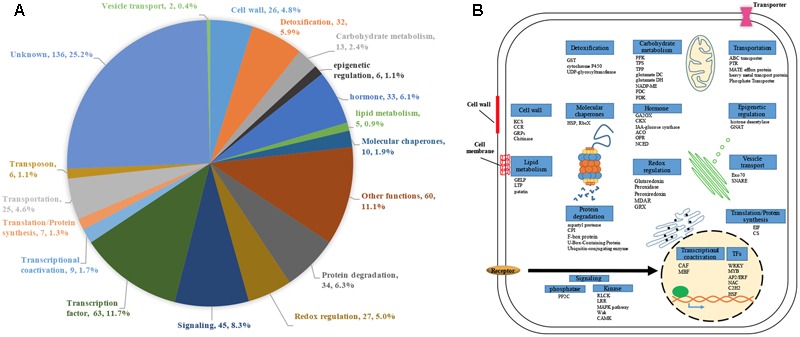
Functional classification of 539 GSR genes. Genes that were up-regulated (fold change ≥ 2, p < 0.05) under all eight rhizotoxins used in this study were termed GSR genes. (A) Pie charts representing different proportion of each category in GSR genes. For each category, category name, number of GSR genes in the category and percentage of total GSR genes were shown. Each gene was assigned to a specific functional category based on information from the following sources: GOslim terms, MapMan, gene description in the database of Rice Genome Annotation Project, and literatures. (B) Schematic diagram of a plant cell showing the representative genes under each GSR category. Genes are identified by abbreviation names. ACO, 1-Aminocyclopropane-1-carboxylic acid oxidase; CAF, CCR4-associated factor; CCR, cinnamoyl-CoA reductase; CKX, cytokinin dehydrogenase; CPI, Chymotrypsin protease inhibitor; CS, cysteine synthase; EIF, eukaryotic translation initiation factor; GA2OX, gibberellin 2-beta-dioxygenase; GELP, GDSL esterase/lipase protein; glutamate DC, glutamate decarboxylase; glutamate DH, glutamate dehydrogenase; GRPs, Glycine-rich proteins; GNAT, GCN5-related N-acetyltransferase; GST, glutathione-S-transferase; HSPs, heat shock proteins; KCS, 3-ketoacyl-CoA synthase; LTP, lipid transfer protein; MBF, multiprotein bridging factor; MDAR, monodehydroascorbate reductase; NADP-ME, NADP-dependent malic enzyme; NCED, 9-cis-epoxycarotenoid dioxygenase; OPR, 12-oxophytodienoate reductase; PDC, pyruvate decarboxylase; PDK, Pyruvate dehydrogenase kinase; PFK, 6-phosphofructokinase; RbcX, Chaperonin-like RbcX family protein; TFs, transcription factors; TPP, trehalose-6-phosphate phosphatase; TPS, trehalose-6-phosphate synthase; PTR, peptide transporter; PP2C, protein phosphatase 2C.